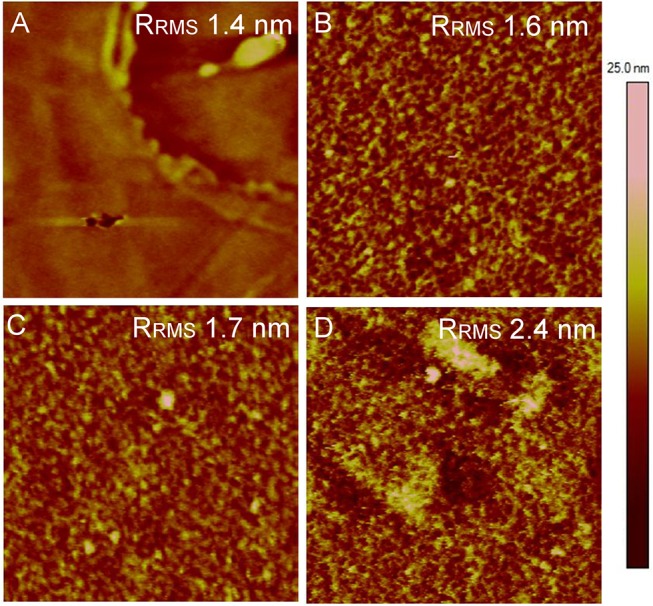
AFM topography images.(A) TCPS, (B) (Alb/Hep)2 assembly, (C) (Alb/Hep)2 with FGF-2ads (30 ng/cm2), (D) (Alb/Hep)2 with FGF-2ads (120 ng/cm2) in PBS. The root mean squared surface roughness (RRMS) is depicted in each image. Image size: 1 × 1 μm, Z-scale: 25 nm.